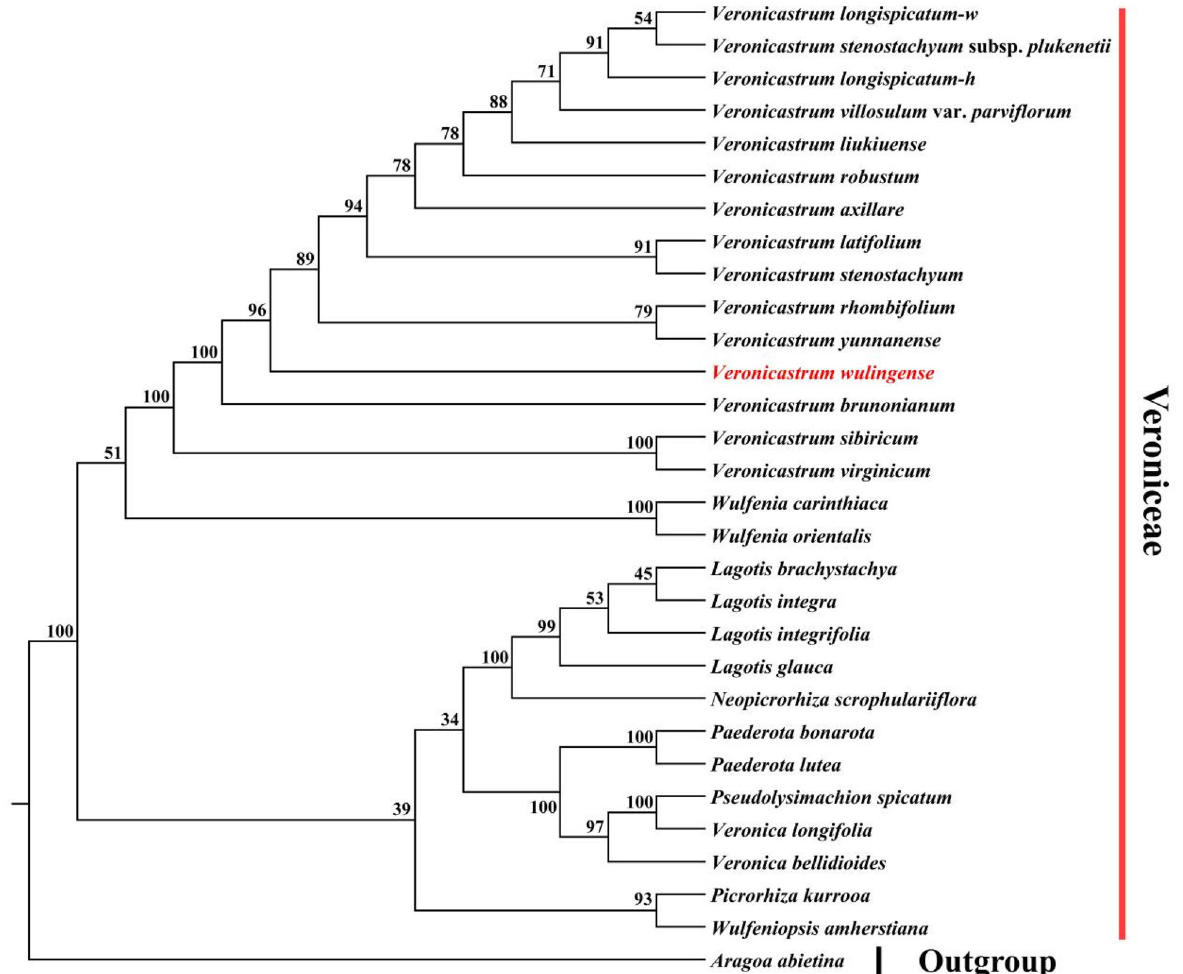
Fig. 3 The phylogenetic position of V. wulingense in the genus Veronicastrum based on the maximum likelihood (ML) method using 30 concatenated matrix sequences from ITS (internal transcribed spacer) and plastid fragment trnL-F